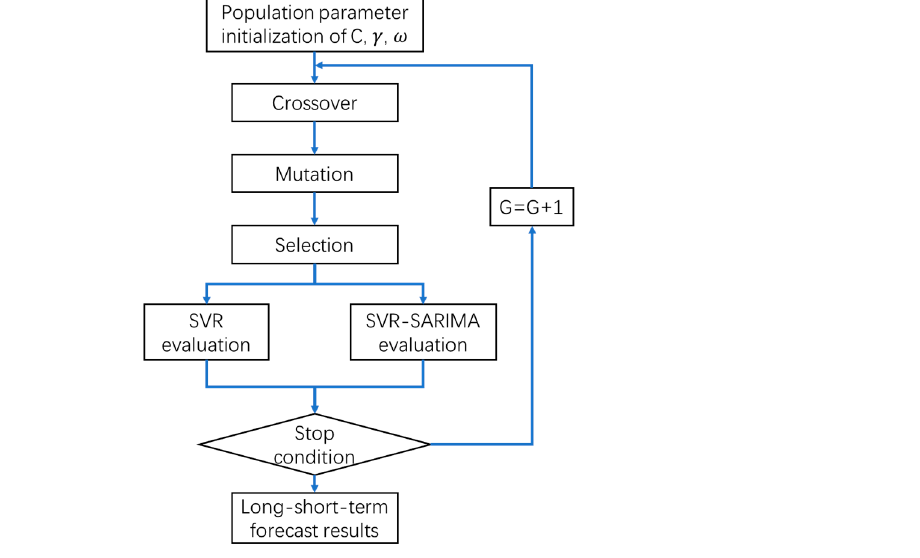
Figure 3. The parameter optimization framework for long-term and short-term models.